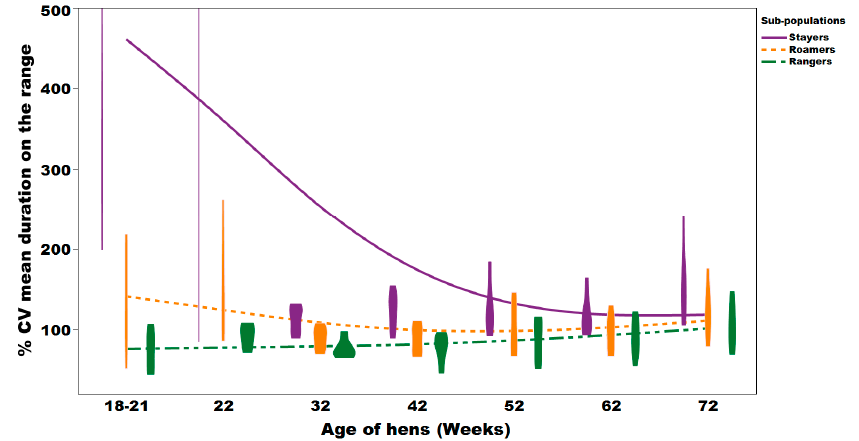
Figure 6. Individual variation of Lohmann brown free-range laying hens as shown by the% CV of average time duration on the range/day. A violin plot with an overlay of smooth spline (lambda = 3.5) representing the distribution and the% CV trend of stayers, roamers and rangers.